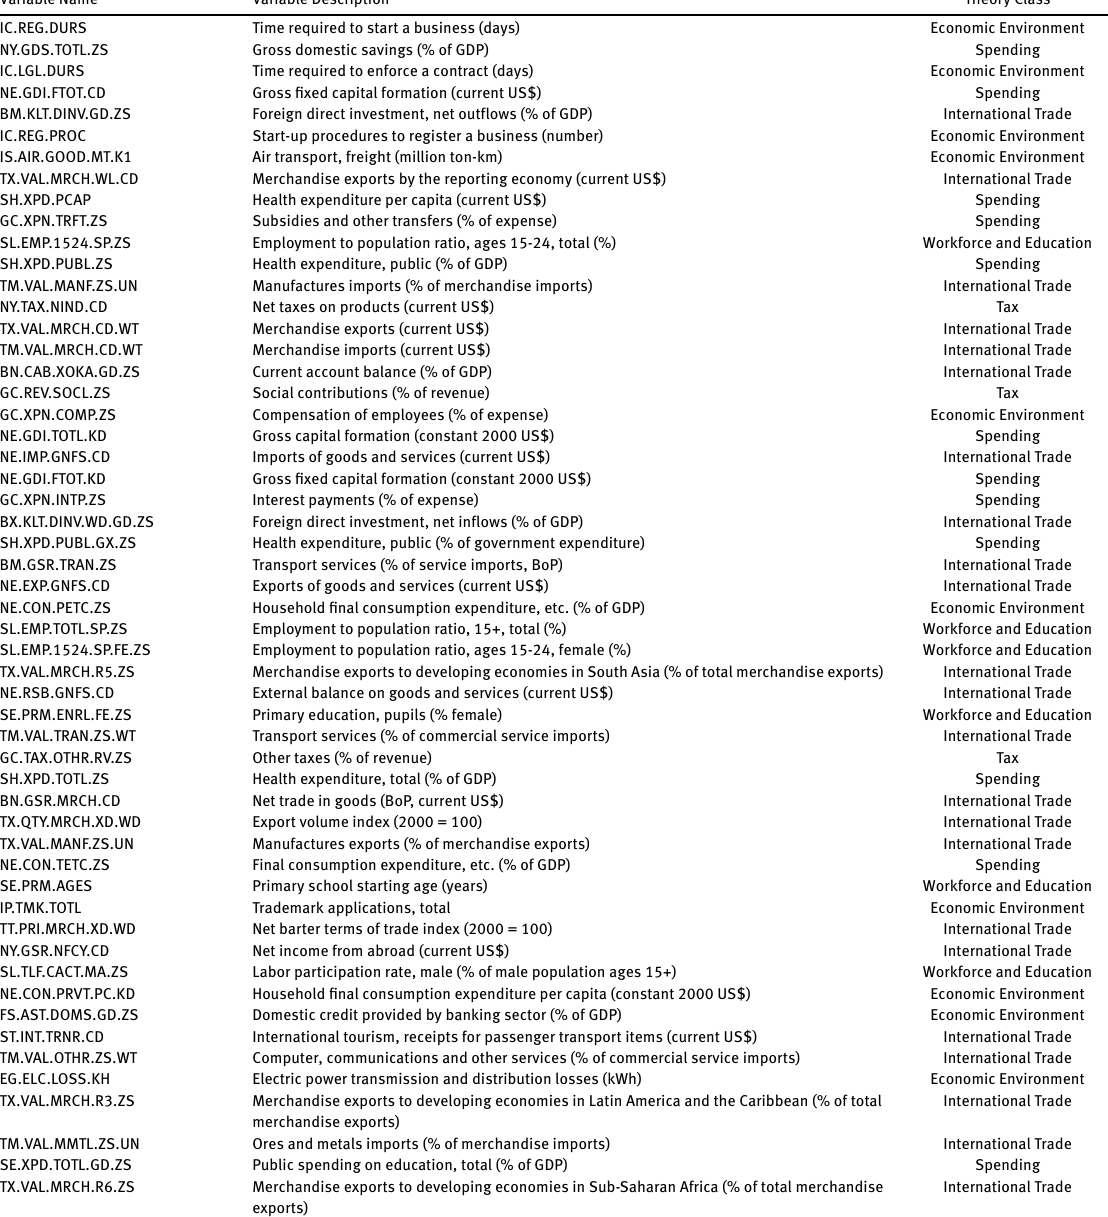
Table 10: List of Applied Risk Indicators